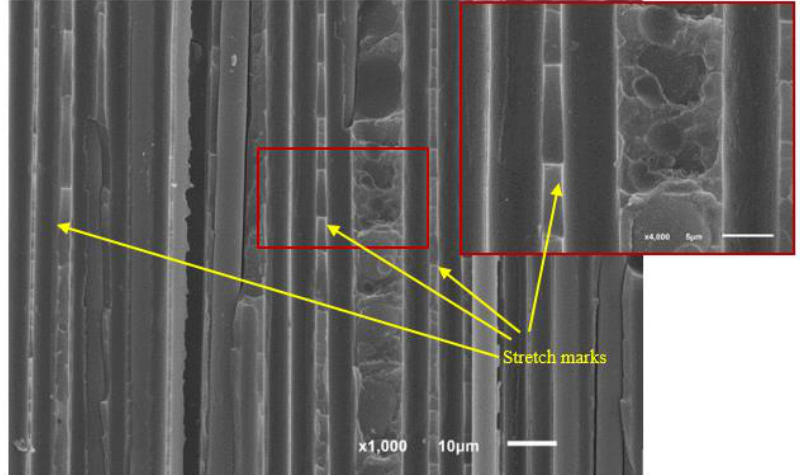
Figure 13. SEM micrographs of an ADCB fatigue specimen showing the presence of cusps and stretch marks.